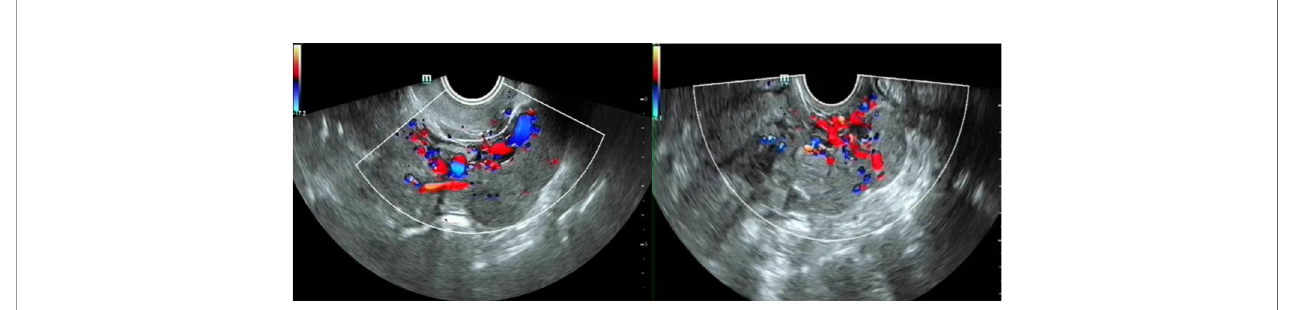
FIGURE 1 | Contrast-enhanced ultrasonography imagine of case 2.